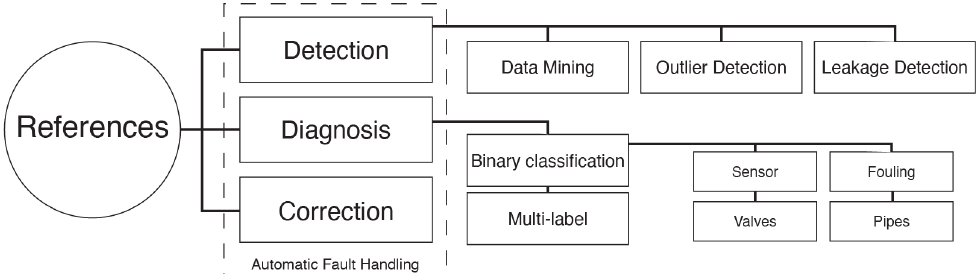
Figure 4. Literature categories based on automatic fault